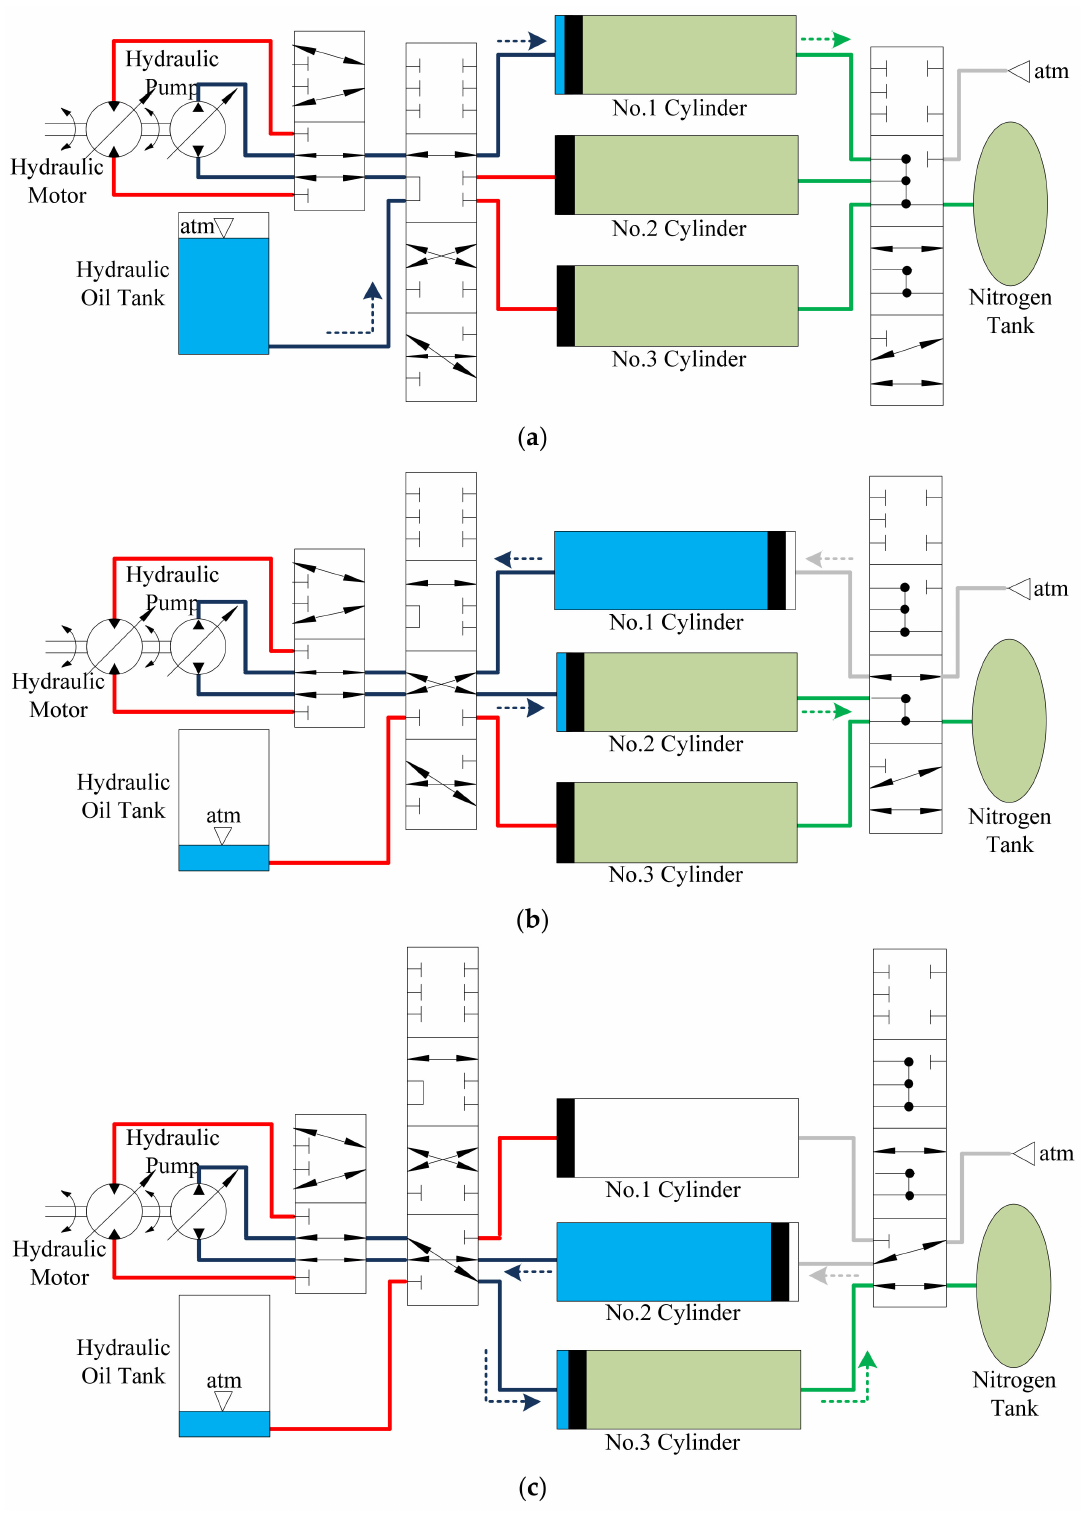
Figure 5. Operation method of OHESS: ( a ) Recovering stage I (Releasing stage III); ( b ) Recovering II (Releasing stage II); ( c ) Recovering stage III (Releasing stage I)